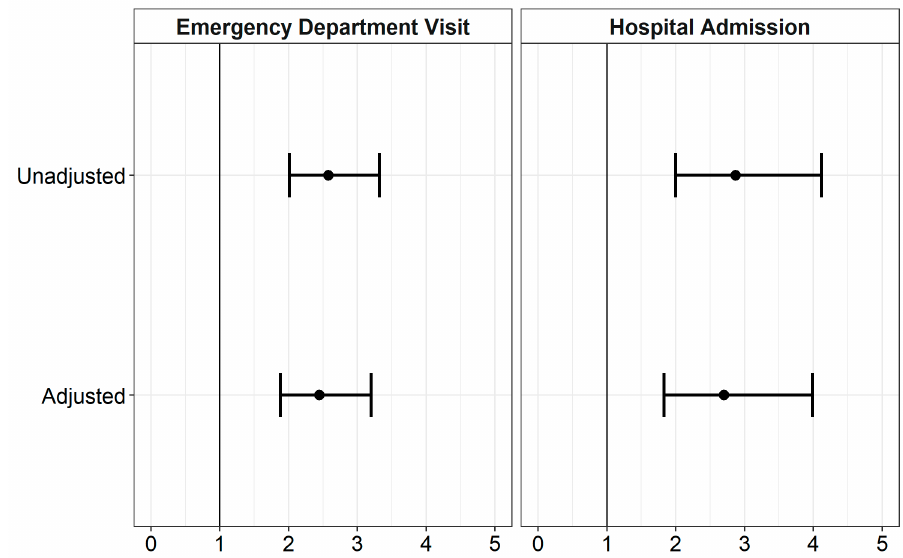
Figure 2. Unadjusted and adjusted relative risk estimates with 95% con fi dence intervals for